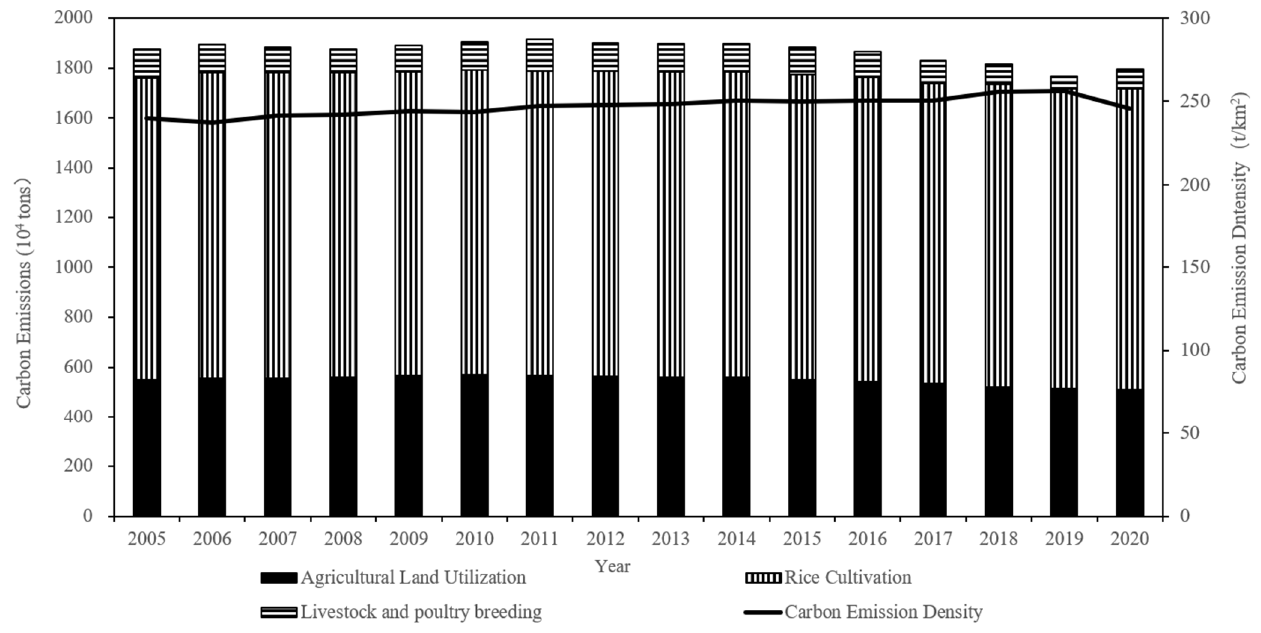
Figure 3. Change in ACEs and ACED in Jiangsu Province, China: 2005–2020.